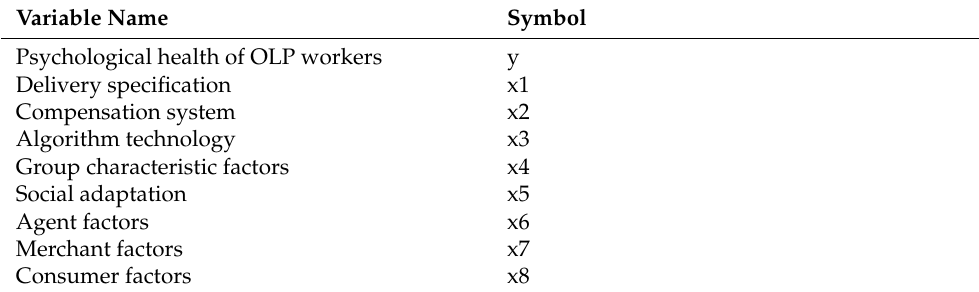
Table 7. Variable selection and symbol